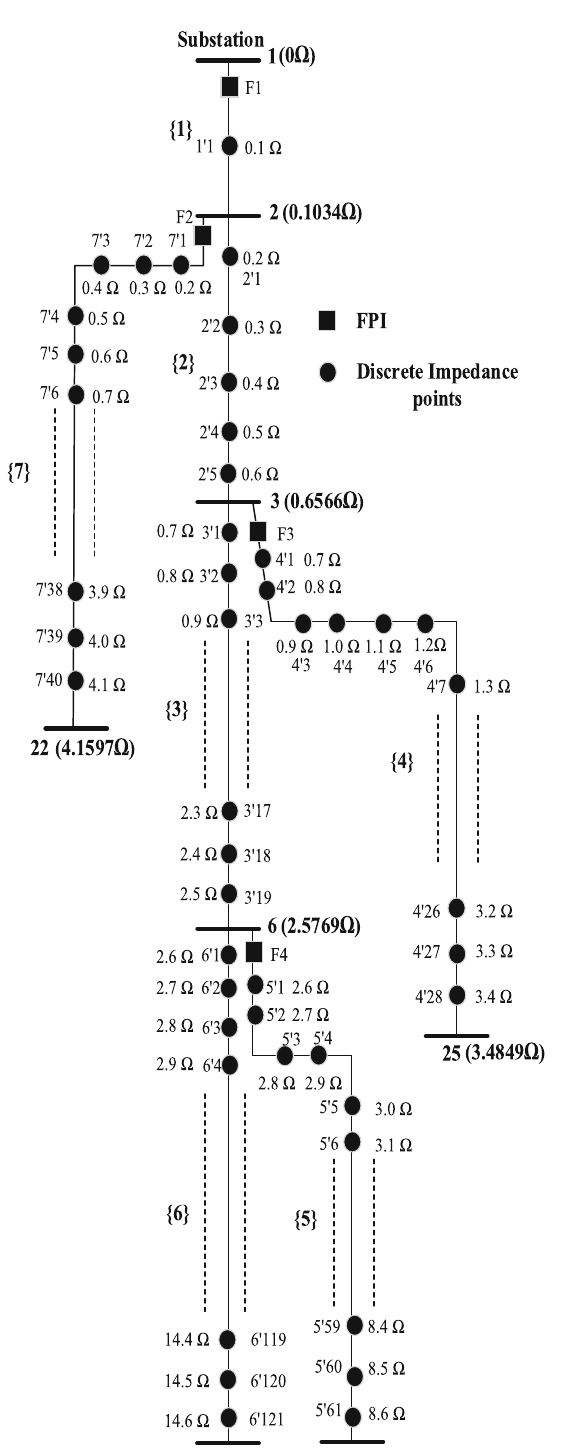
Fig. 9 Four FPI placed with discrete impedance points for IEEE 33 bus distribution network